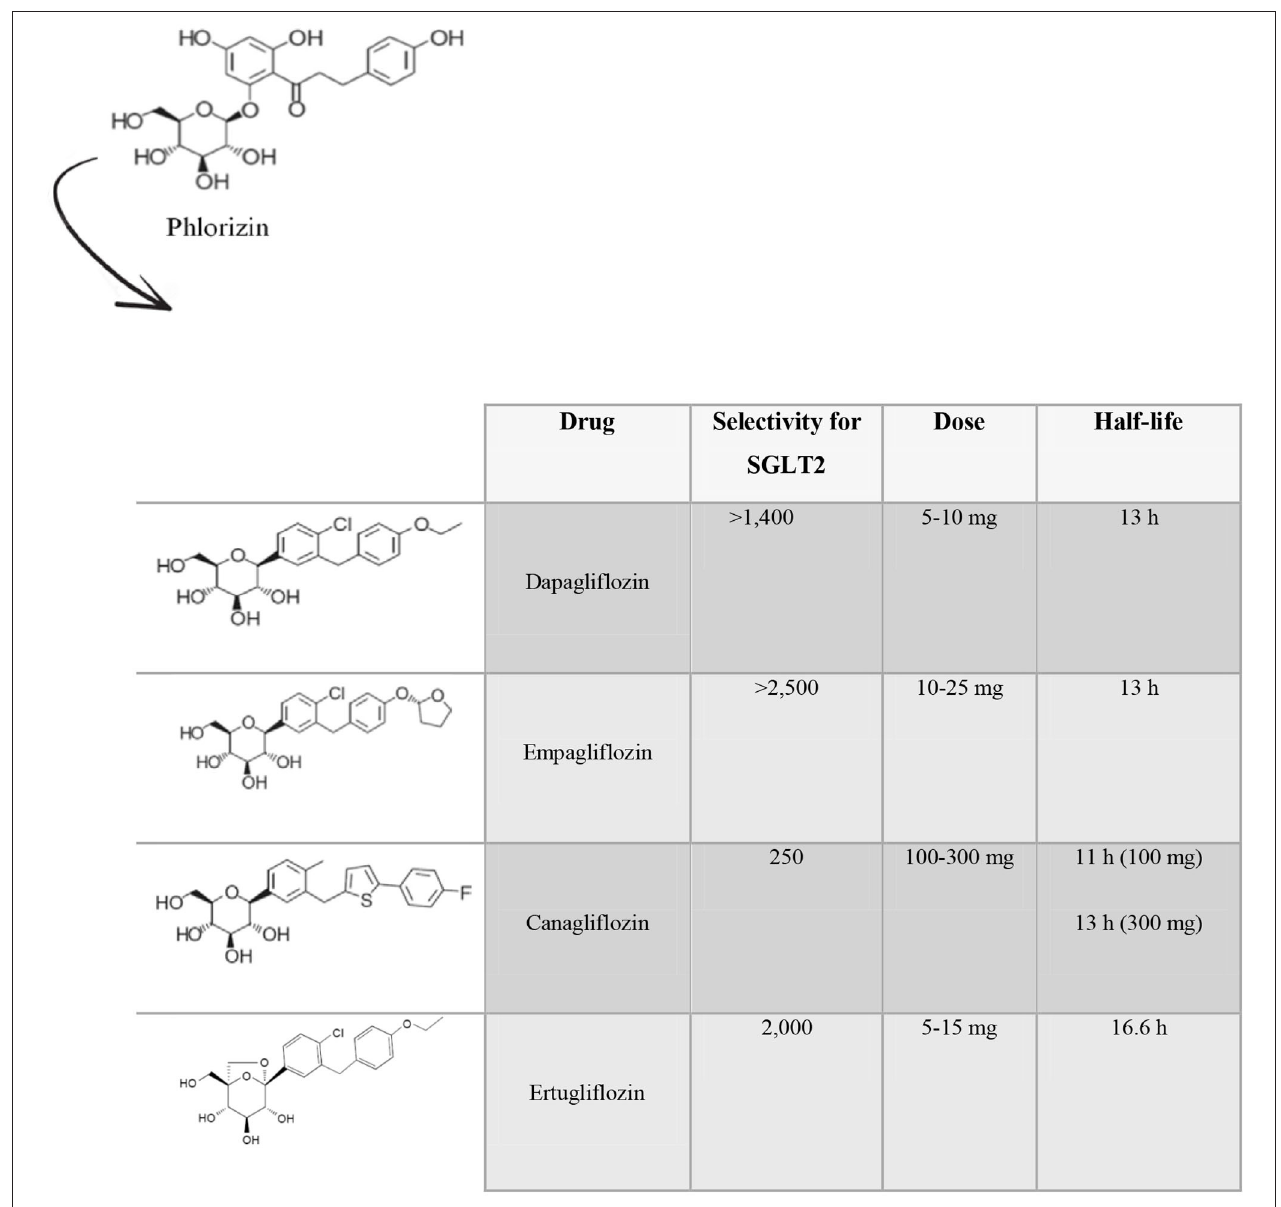
FIGURE 1 | Molecular and pharmacokinetics characteristics of the principal SGLT2 inhibitors. Phlorizin was the first SGLT2 inhibitor discovered. Later, several gliflozins have been developed, keeping the active center of phlorizin and implementing structural changes in order to achieve a better bioavailability, selectivity for SGLT2 and decrease their side effects. Only four molecules have received Food and Drug Administration approval for the treatment of type 2 diabetes namely dapagliflozin, empagliflozin, canagliflozin, and